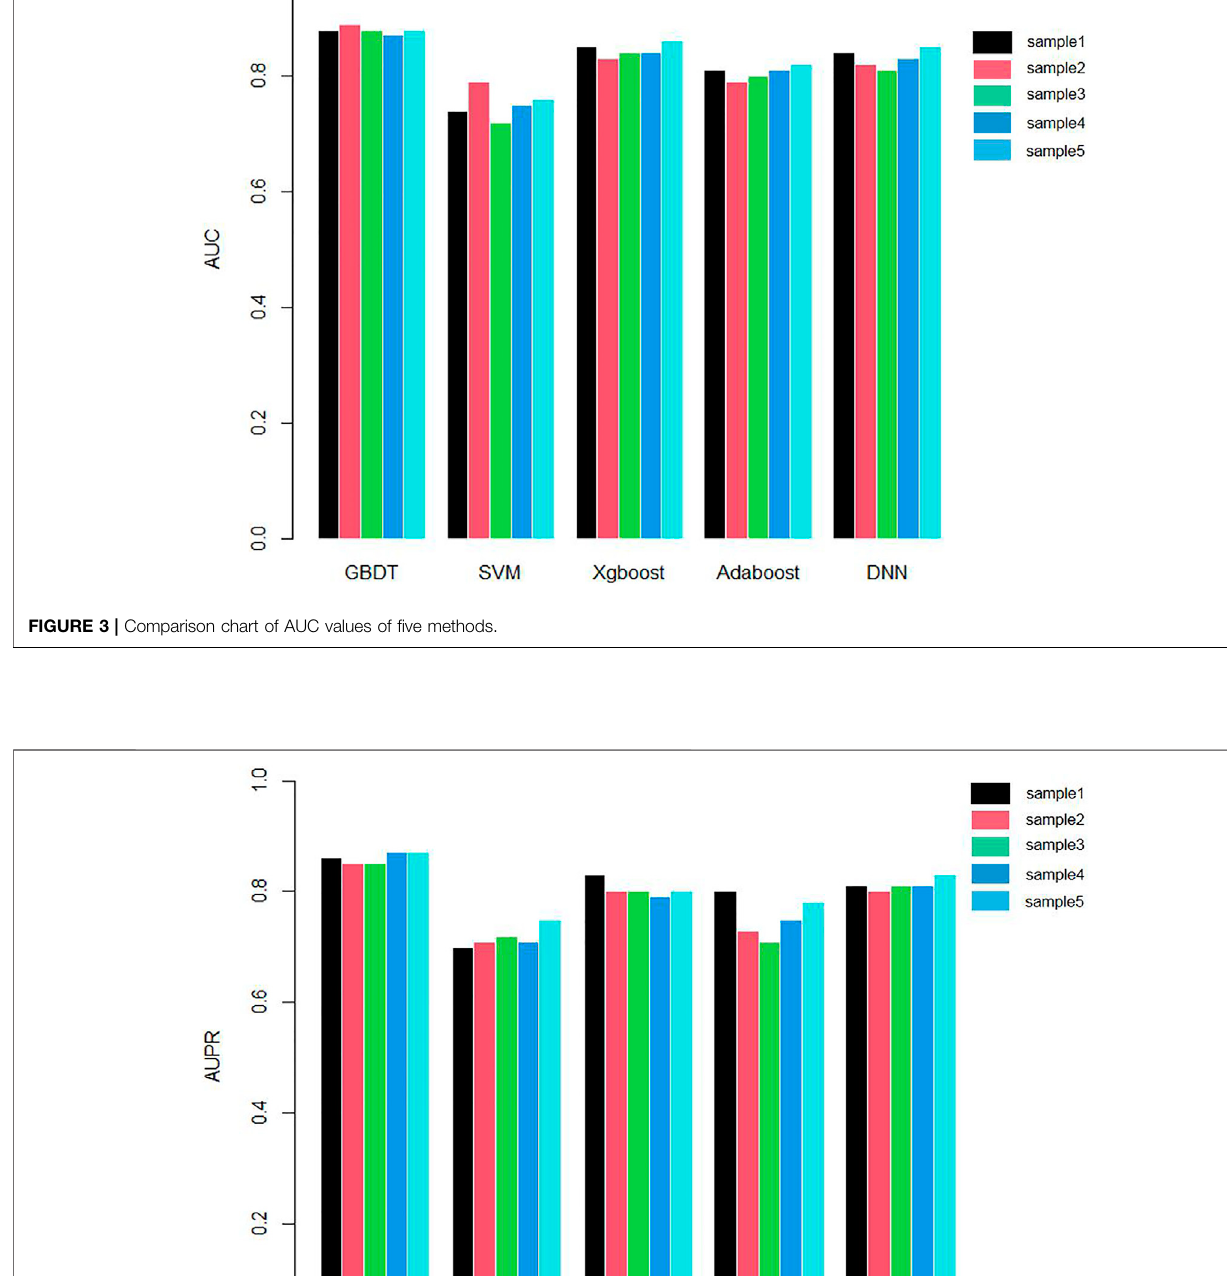
Frontiers in Molecular Biosciences |